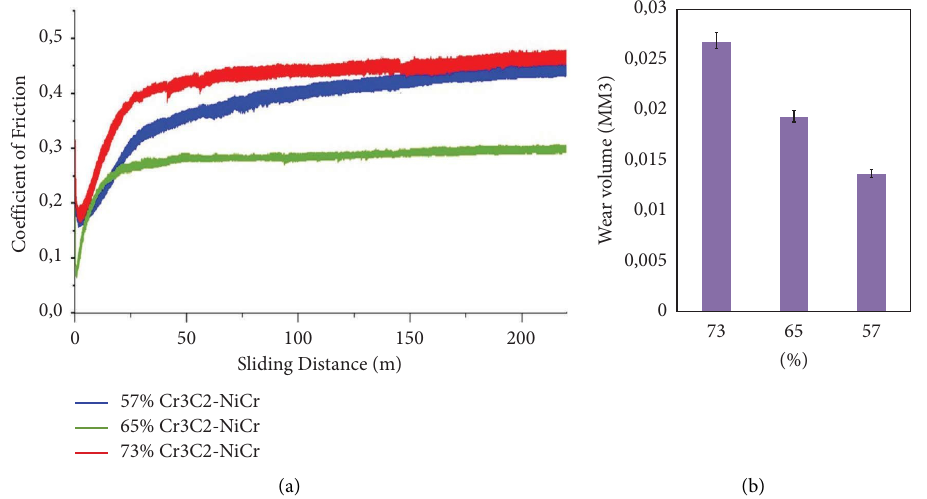
Figure 6: Results of tribological testing of Cr